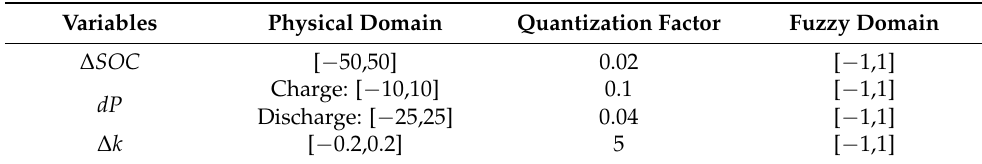
Table 1. Relationship between physical and fuzzy